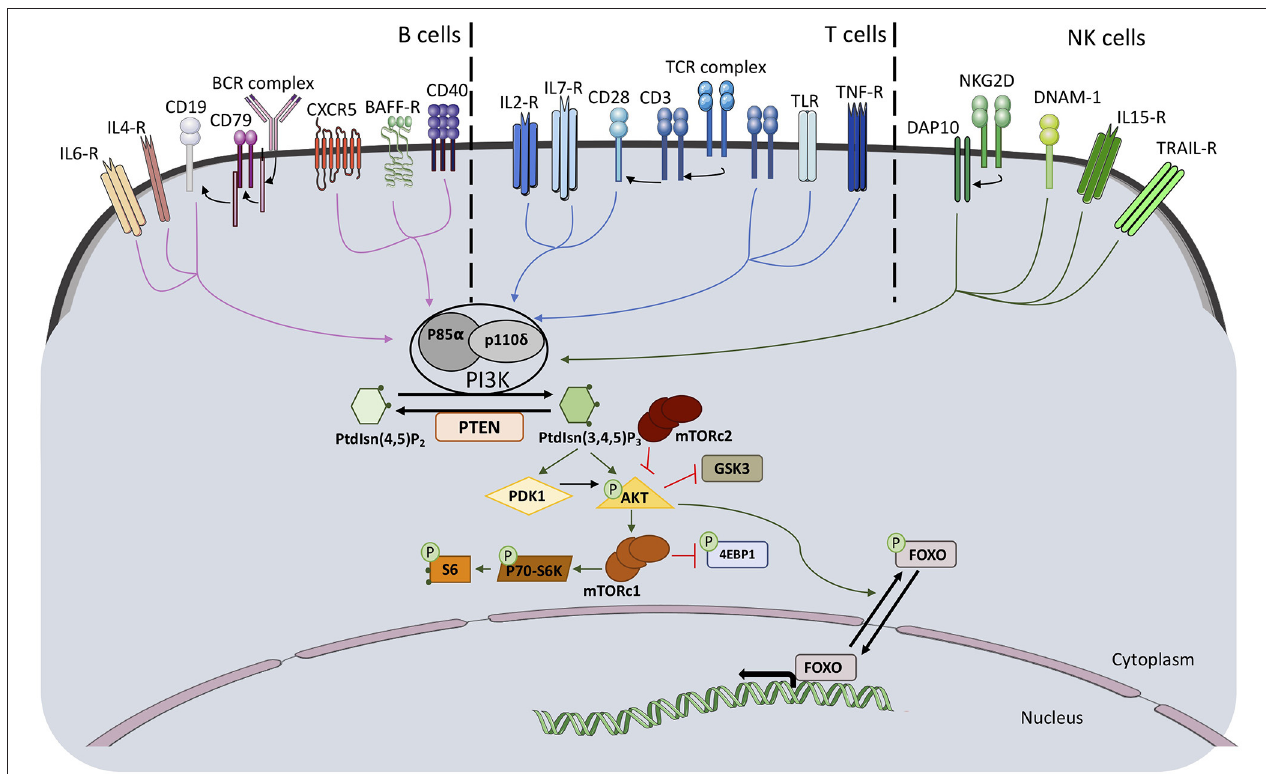
FIGURE 1 | Schematic representation of PI3K pathway activation and downstream signaling molecules in B, T, and NK cells.